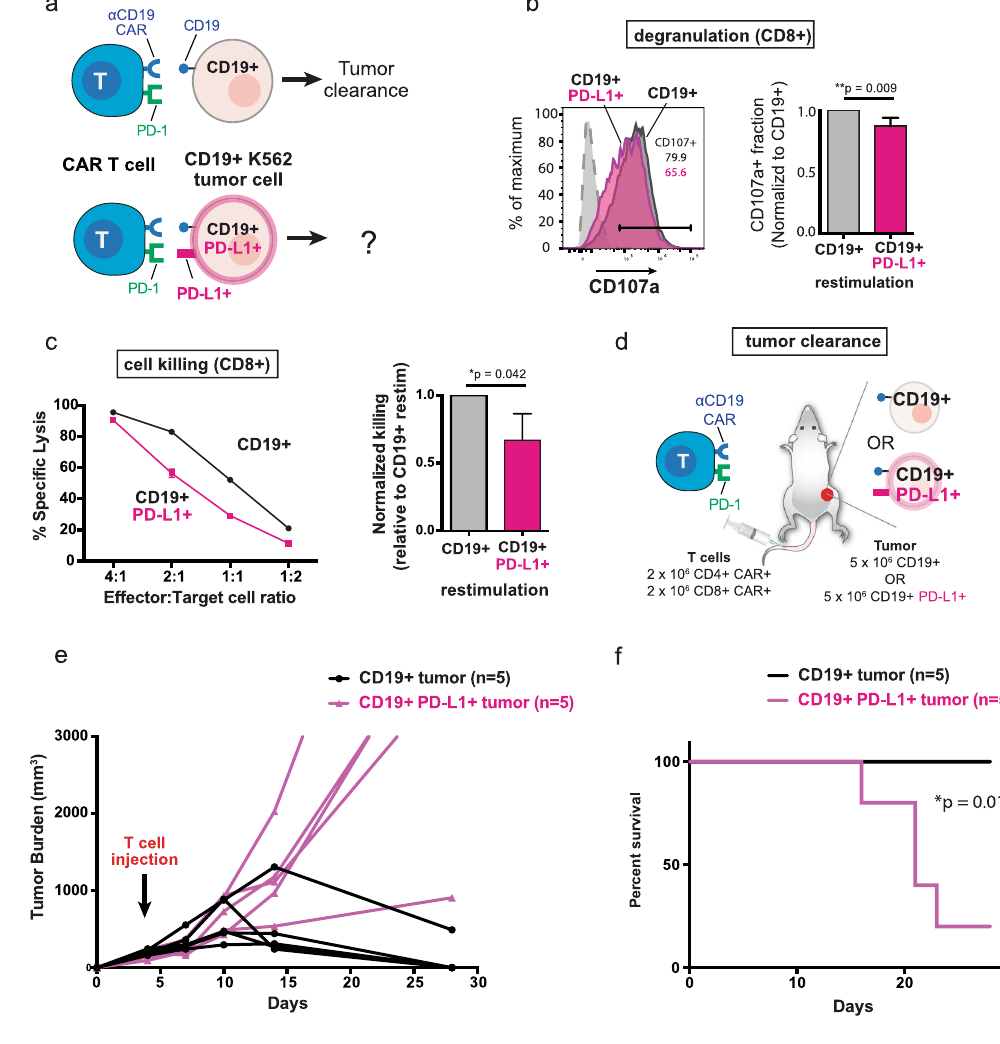
Figure 1. PD-L1 expression in human K562 myelogenous leukemia cells inhibits anti-CD19 CAR T cell function in vitro and tumor clearance in vivo . ( a ) Schematic representation of CAR T cell interaction with either CD19 + or CD19 + PD-L1 K562 tumor cells. ( b ) CD8 + anti-CD19 CAR T cells exhibit reduced degranulation (CD107a staining) upon re-stimulation with CD19 + PD-L1 + K562 cells. Representative CD107a staining is shown, gated on CD8 + CAR + T cells. Normalized CD107a staining shows ~15% reduction in degranulation upon co-culture with CD19 + PD-L1 + targets over three independent experiments ( ** p = 0.009, Student’s t-test). ( c ) CD19 + PD-L1 + K562 cells are resistant to anti-CD19 CAR-mediated lysis in an in vitro killing assay. Left panel: a complete effector:target ratio titration is shown for a representative experiment. Mean ± S.D. for triplicate wells in a single experiment are plotted. Right panel (bar chart): CD19 + PD-L1 + K562 cells induce ~40% reduction in specific lysis relative to CD19 + K562 cells at effector:target ratio of 2:1 ( * p = 0.042, Student’s t-test). The experiment was performed three times; error bars are S.D. ( d ) Experimental design for subcutaneous xenograft model. ( e ) CD19 + PD-L1 + subcutaneous xenografts impair anti-CD19 CAR mediated tumor clearance. NOD- scid -IL-2R γ − / − (NSG) mice were injected with 5 × 10 6 CD19 + or CD19 + PD-L1 + K562 cells subcutaneously. Mice with established tumors (100–250 mm 3 ) were injected intravenously with 2 × 10 6 CD4 + and 2 × 10 6 CD8 + anti-CD19 CAR T cells and tumor burden measured longitudinally by caliper. Shown are tumor burdens for individual mice (n = 5 per tumor type). ( f ) Kaplan-Meier curve for experiment described in Fig. 1E. A statistically significant difference in survival was observed between animals bearing CD19 + vs. CD19 + PD-L1 + tumors ( * p = 0.016, Gehan-Breslow-Wilcoxon